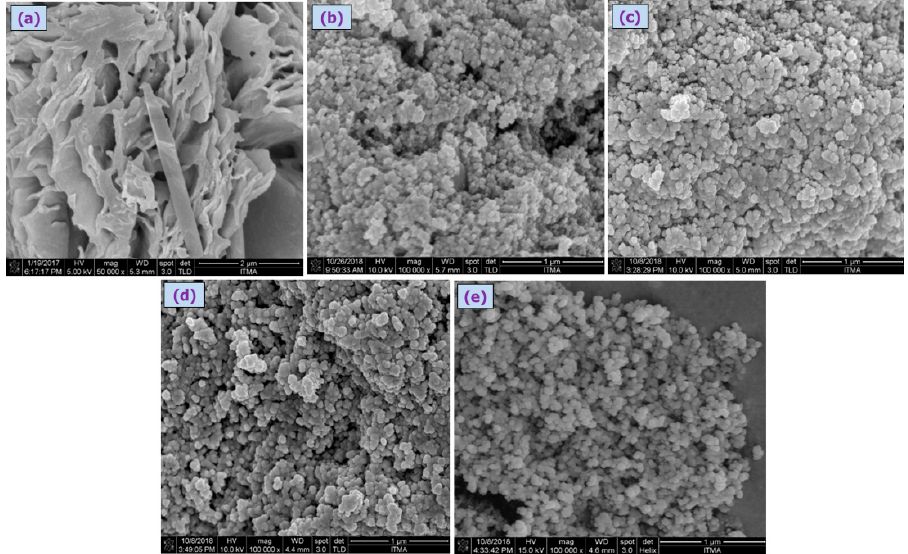
Figure 5. SEM images of ( a ) poly(4,4’-cyclohexylidene bisphenol oxalate), ( b ) poly(4,4’-cyclohexylidene bisphenol oxalate)/Si(3.7%) NC, ( c ) poly(4,4’-cyclohexylidene bisphenol oxalate)/Si(7%) NC, ( d ) poly(4,4’-cyclohexylidene bisphenol oxalate)/ Si(13%) NC, and ( e ) poly(4,4’-cyclohexylidene bisphenol oxalate)/Si solution mixture containing 40 wt.% NC.